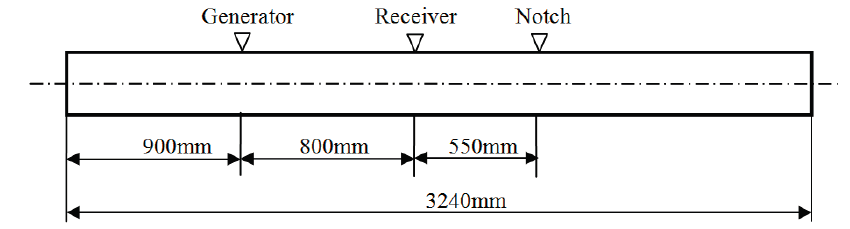
Figure 7. Schematic diagram of the experimental